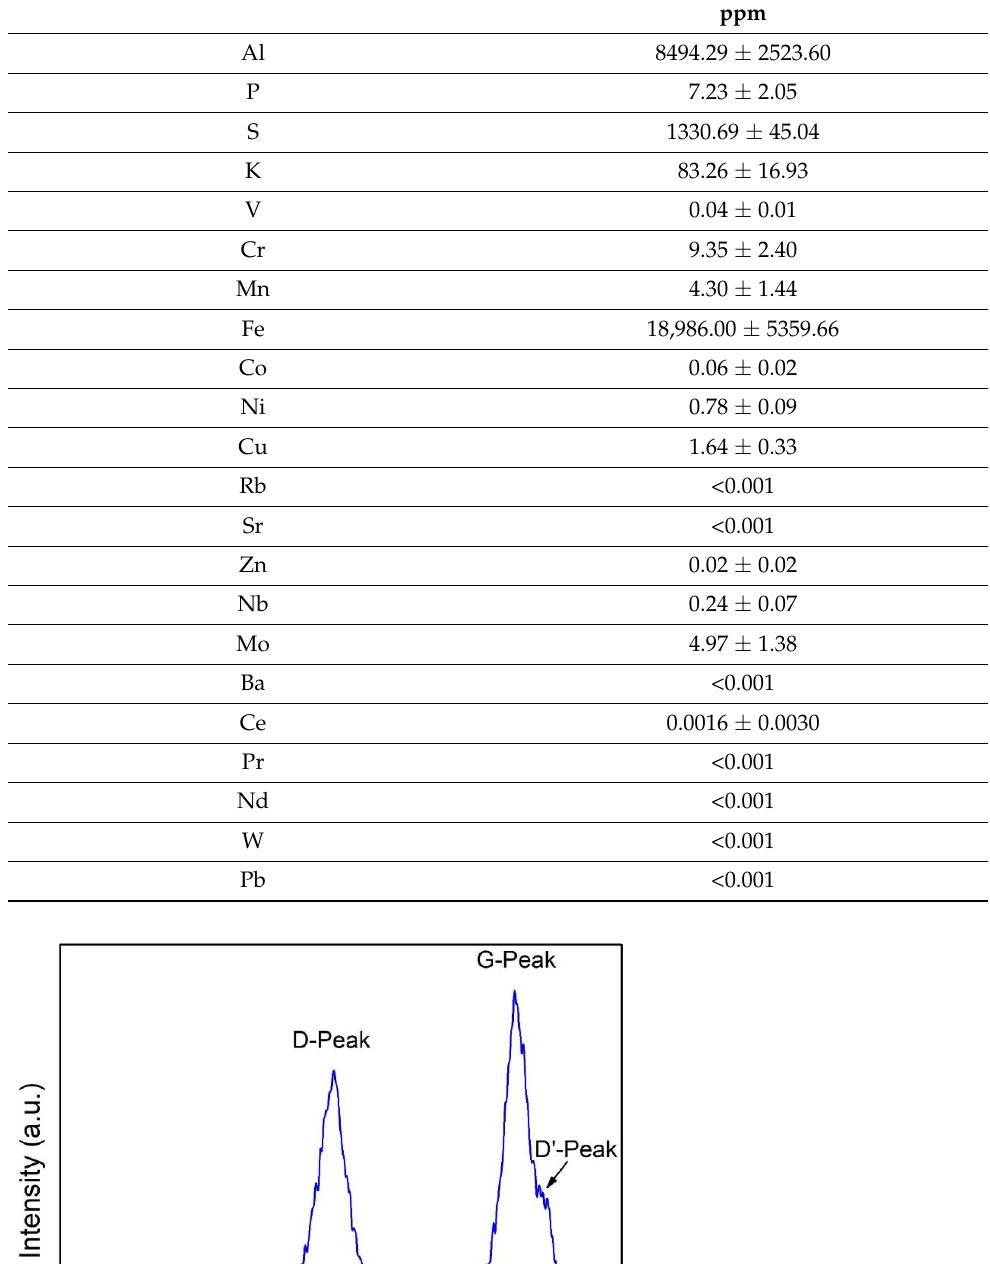
Table 1. Inductively coupled plasma mass spectrometry (ICP-MS) analysis of NTX1 MWCNTs. Values below the detection limit of the ICP-MS procedure are also shown. The displayed values are the averages of two independent determinations.